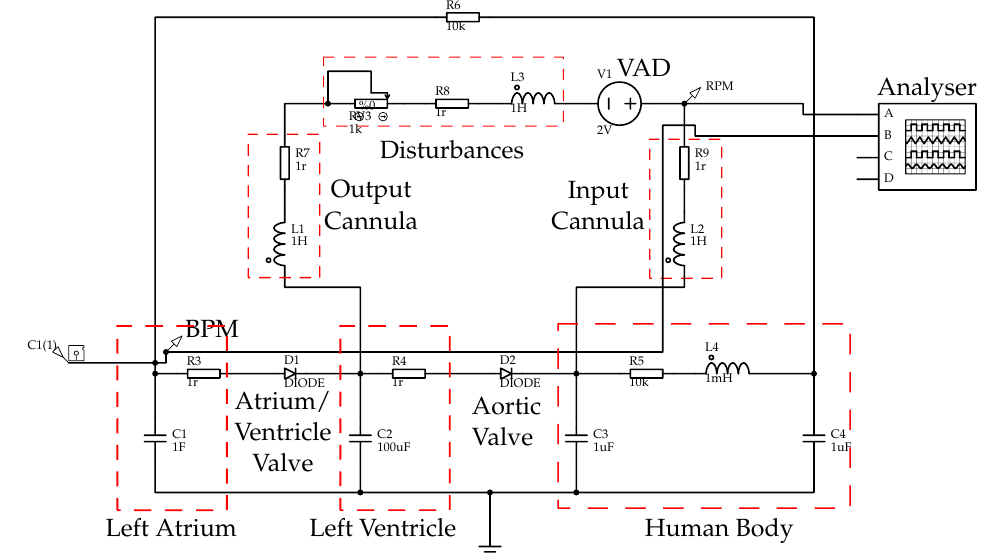
Figure 10. Model adopted to run the cardiovascular system computer simulation. The VAD Motor Pump from Figure 9 is connected at the VAD